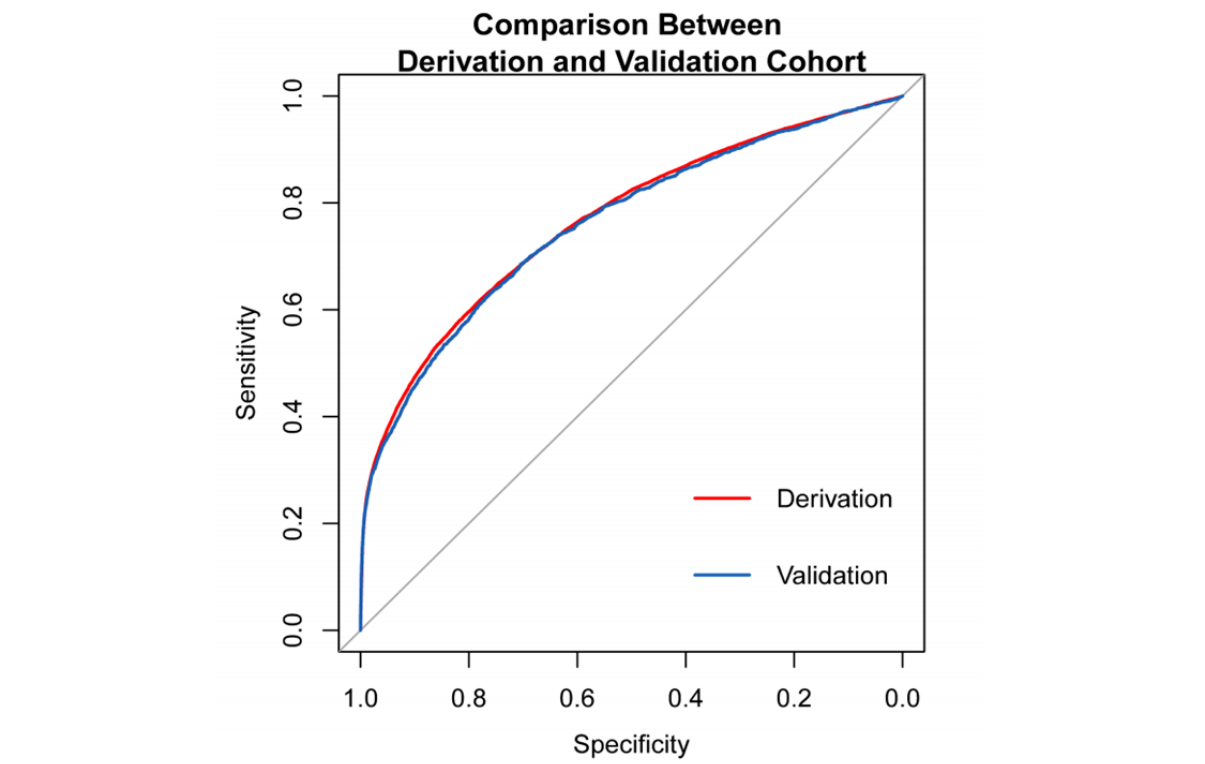
Figure 2. DeLong test for the receiver operating characteristic curves of derivation and validation cohorts.